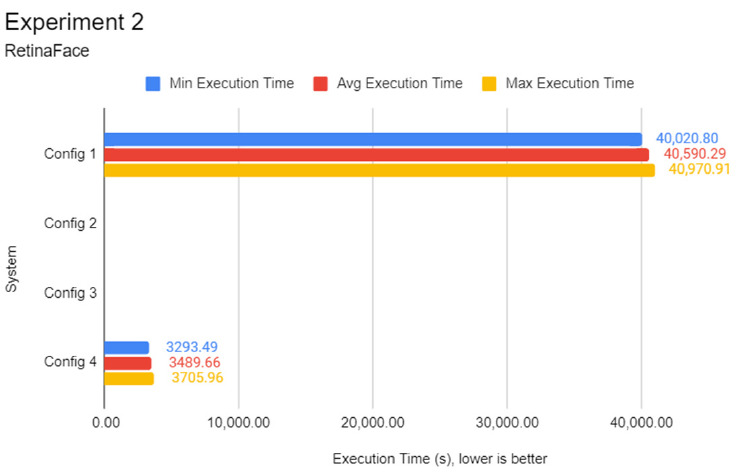
Figure A7. Bar chart execution time results for all systems running RetinaFace on WIDER FACE in Experiment 2. Configurations 2 and 3 are excluded due to Spark OOM error.